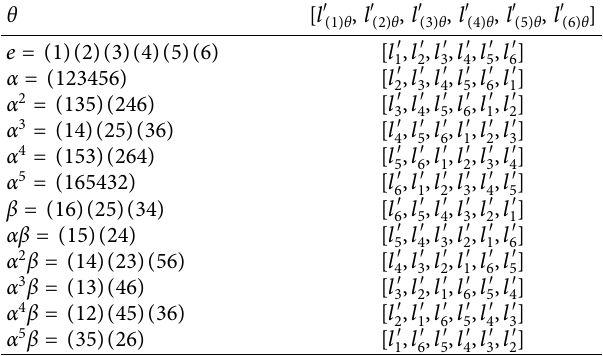
Table 1: Cyclically equivalent circuits of length